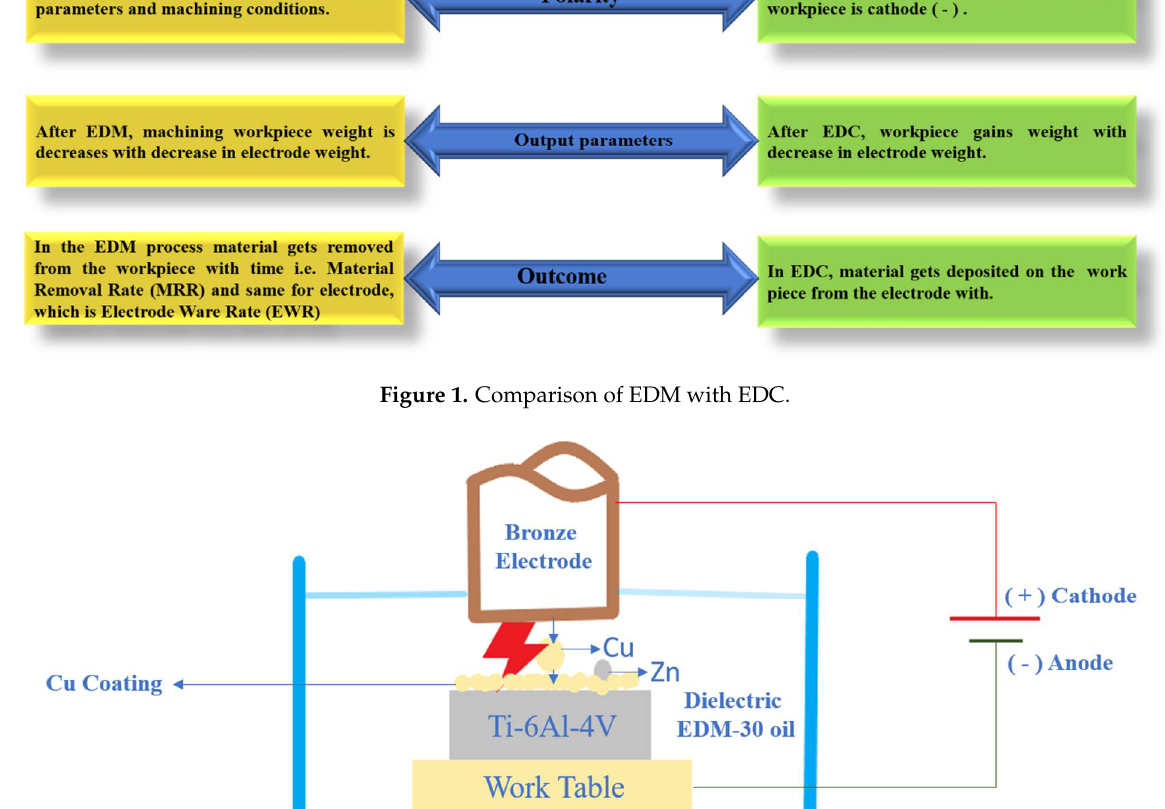
Figure 1. Comparison of EDM with EDC.